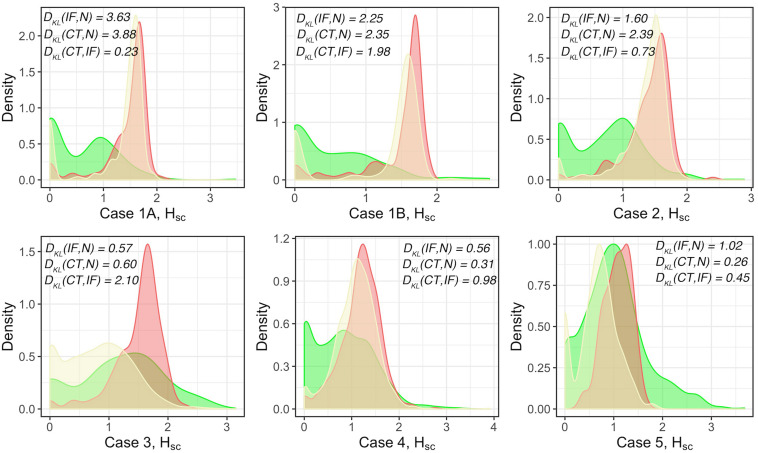
Modified Shannon’s method to quantify the spatial entropy of multitype point patterns, denoted as HSC. Green: normal tissue (N); Red: invasive front (IF); Yellow: central front (CT). For each case, full point patterns for each label are mapped to the same coordinate system and the HSC scores are measured and presented as the PDFs. In general, the higher the HSC score is, the more disorder/heterogeneity the subregion contains. Strong heterogeneity is observed in IF as indicated by the clustered HSC scores across cases.